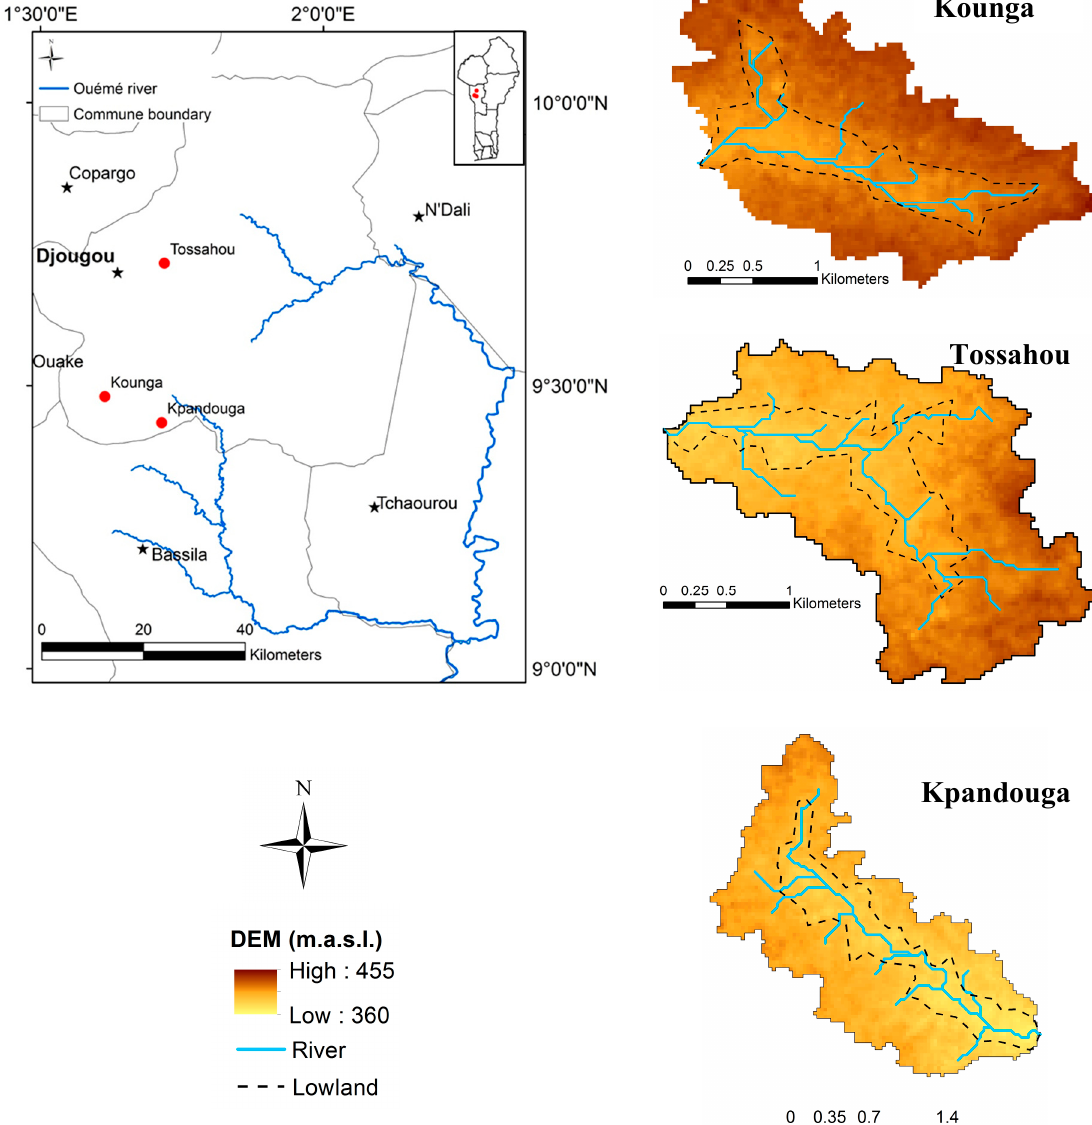
Figure 1. The upper Ouémé watershed and the location of the inland valleys in Benin [42].